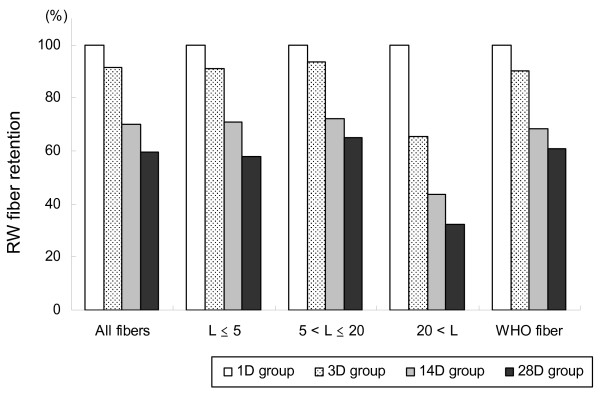
Changes in the intrapulmonary fiber count over time. The percentage of the number of fibers retained in the lungs in each group calculated with the geometric mean of the 1D group taken as 100%.